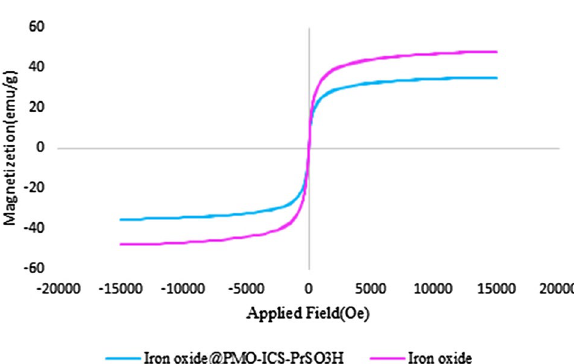
Figure 9. VSM pattern of the iron oxide (purple curve) and the Iron oxide@PMO-ICS-PrSO 3 H mesoporous catalyst ( 1 , blue